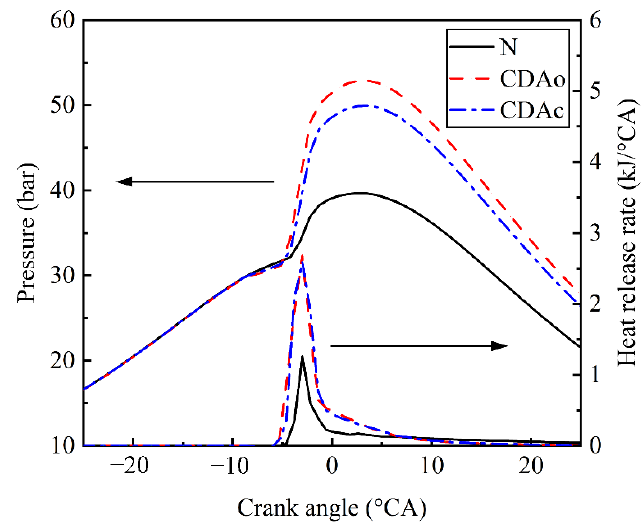
Figure 9. The normalized P-V diagram and combustion heat release at different modes (the calculated results were obtained from 1D simulation of GT-SUITE).